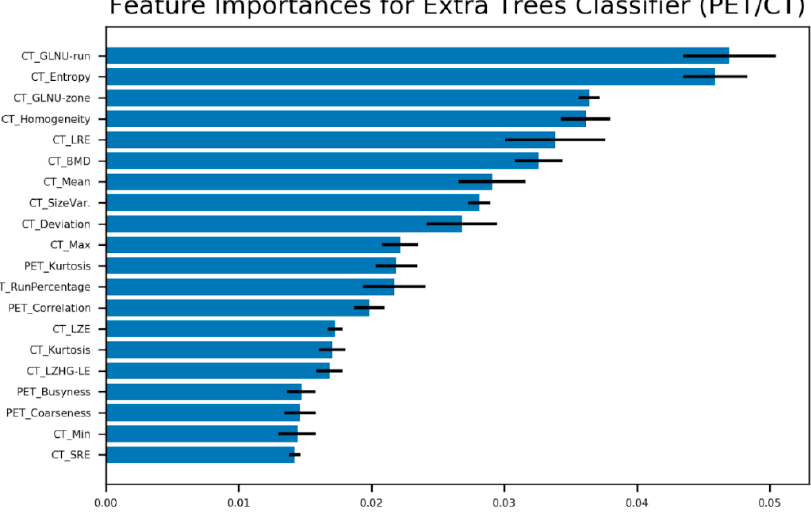
Figure 5. Best 20 features for hotspot classification based on extra trees classifier and five-fold cross-validation. The error bars stand for standard deviation estimated for the CV folds (GreyLevel-NonUniformity (GLNU), LongRunEmphasis (LRE), BoneMineralDensity (BMD), LongZoneEmphasis (LZE), LongZoneHighGrey-LevelEmphasis (LZHG_LE), ShortRunEmphasis (SRE)).